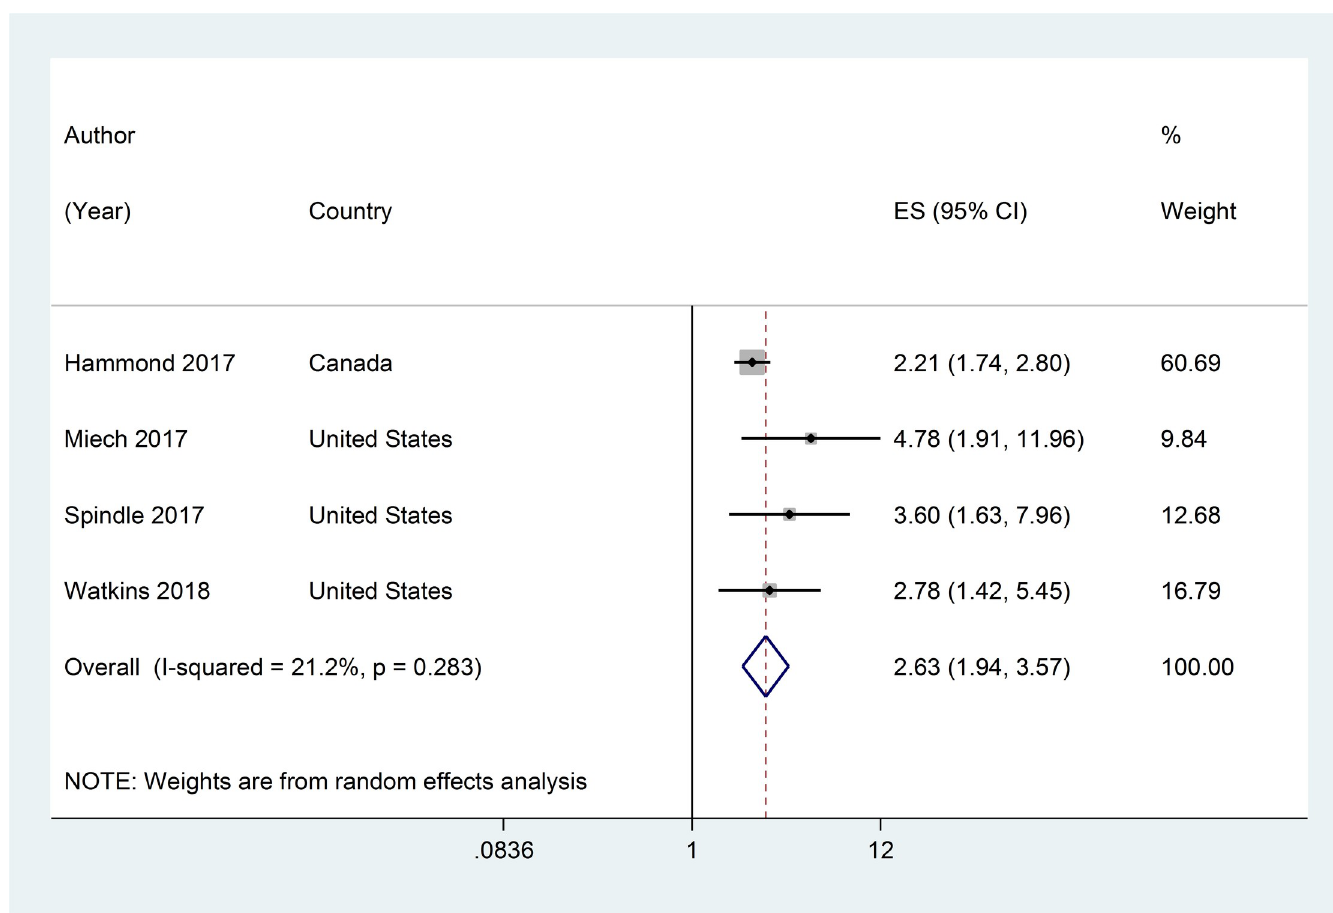
Fig 5. Forest plot of adjusted risk ratios assessing the association between current e-cigarette use at baseline and subsequent ever cigarette use at